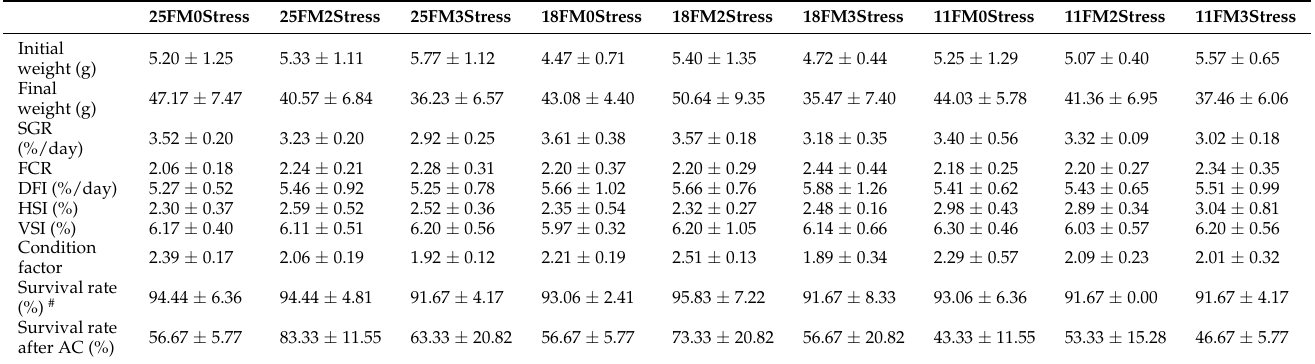
Table 3. Growth performance of oscar ( Astronotus ocellatus ) fed experimental diets under fish meal replacement with meat and bone meal and subjected to varying numbers of